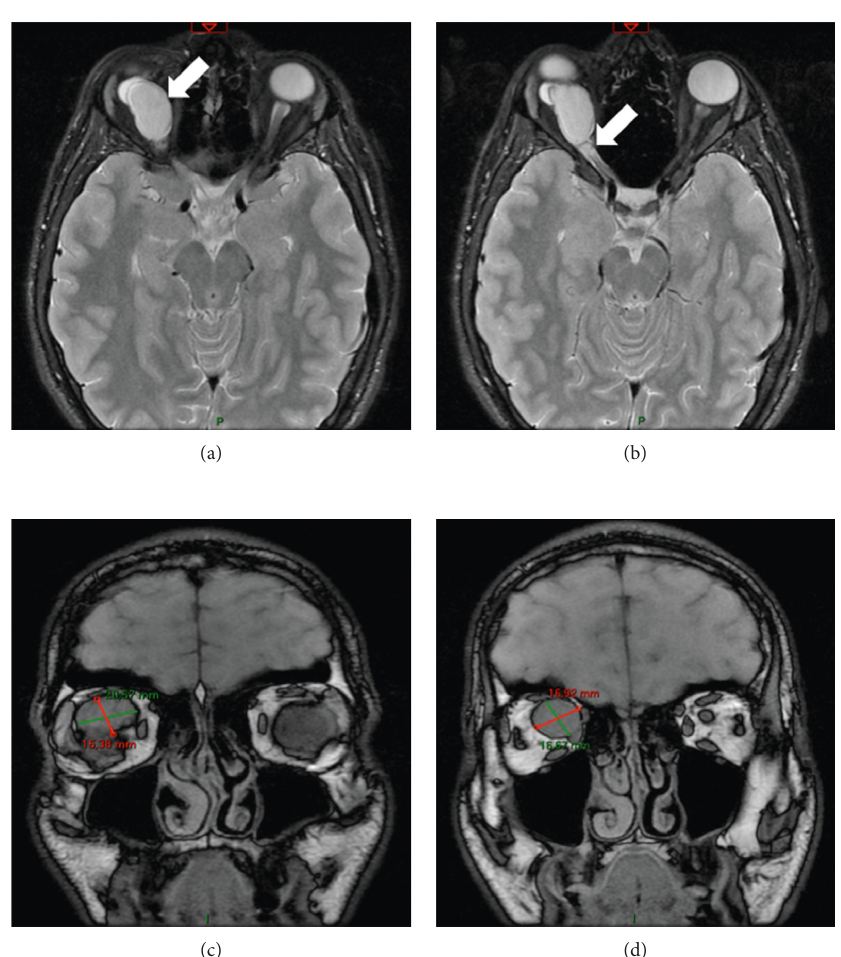
Figure 1: Preoperative MRI scans. (a) A well-defined tumor (white arrow) with vivid signal intensity in the right orbit. (b) The tumor cannot be separated from the optic nerve, followed by the foramen optic (white arrow). (c) The T2-weighted image shows the exact position and size of the tumor. (d) The dorsal edge of the previous